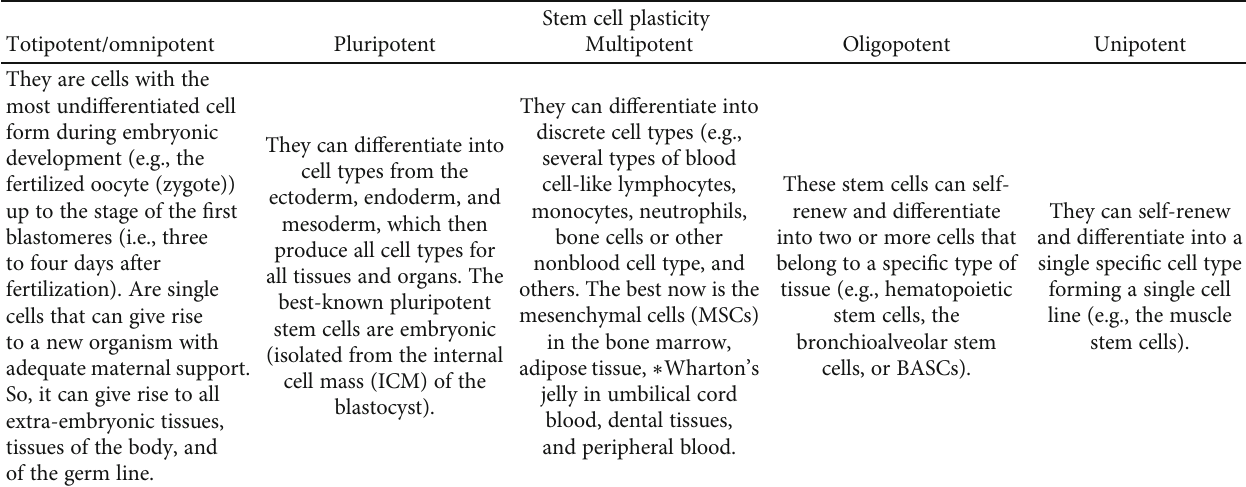
Table 1: The di ff erent sources of stem cells with di ff erent plasticity and di ff erentiation.